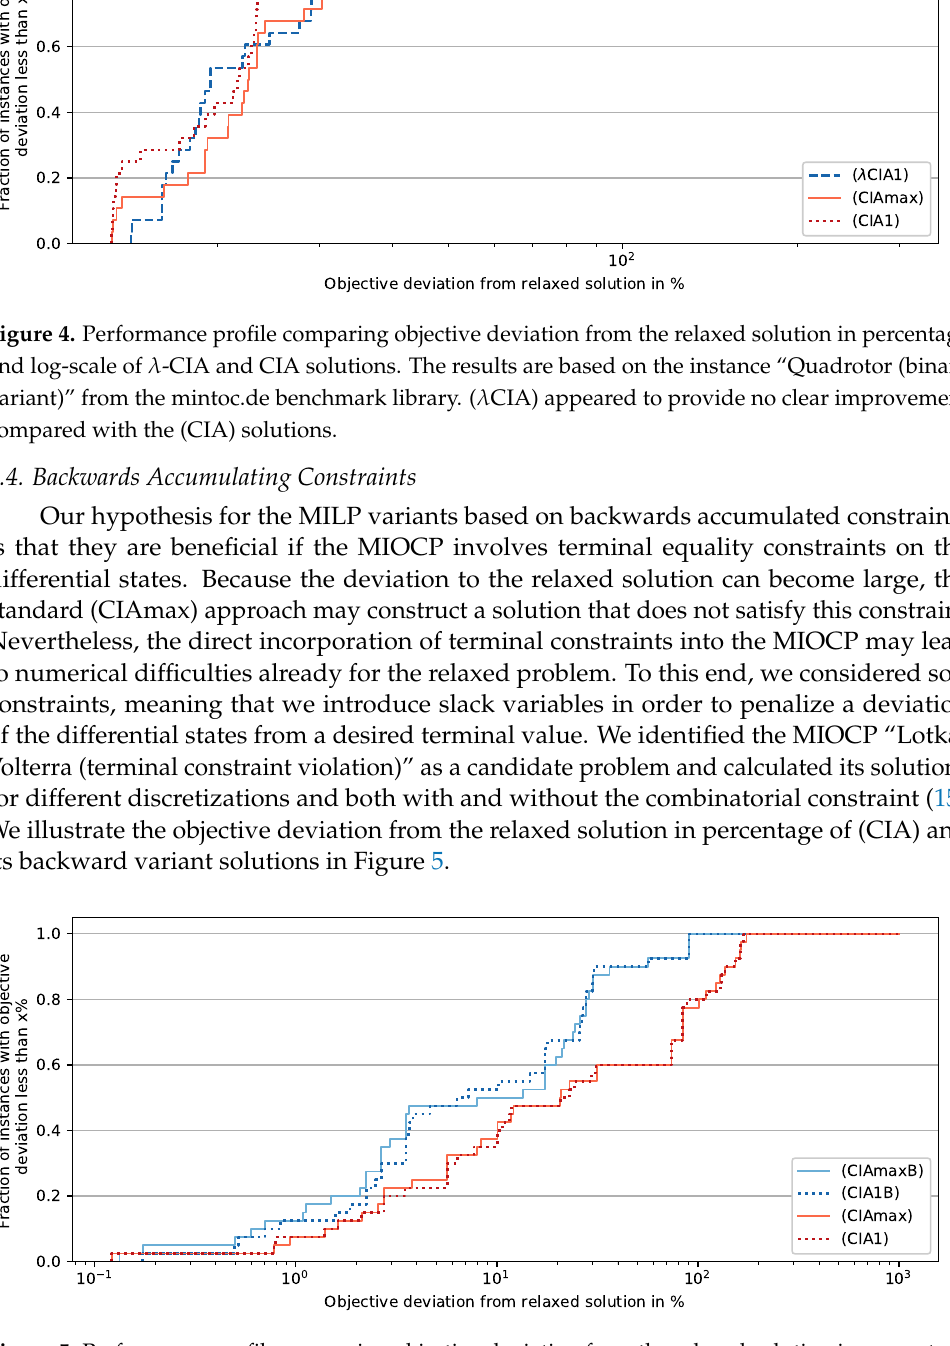
Figure 5. Performance profile comparing objective deviation from the relaxed solution in percentage and log-scale of (CIA) and its backward variant solutions. The results are based on the instance “Lotka–Volterra (terminal constraint violation)” from the mintoc.de benchmark library. Using (CIA1B) or (CIAmaxB) can improve the performance of the CIA decomposition